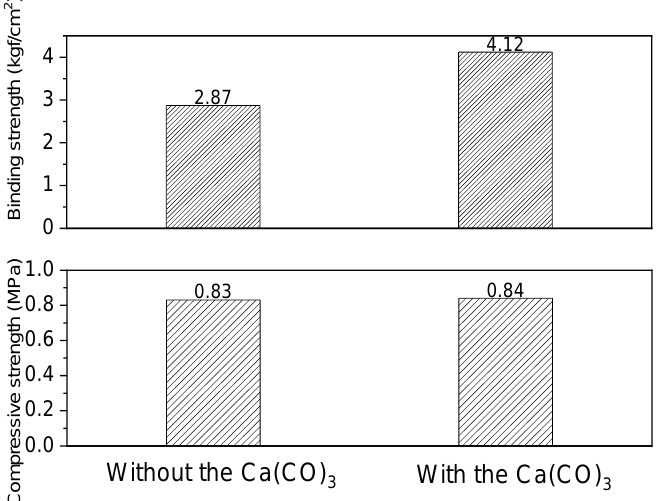
Figure 13. Mechanical properties of bonding and compressive strength of the optimum compositions of the MKPCs.